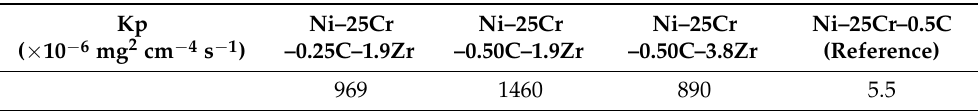
Table 5. The values of the oxidation parabolic constants Kp as classically determined, for the three Zr–containing alloys; comparison with the reference ternary alloy.